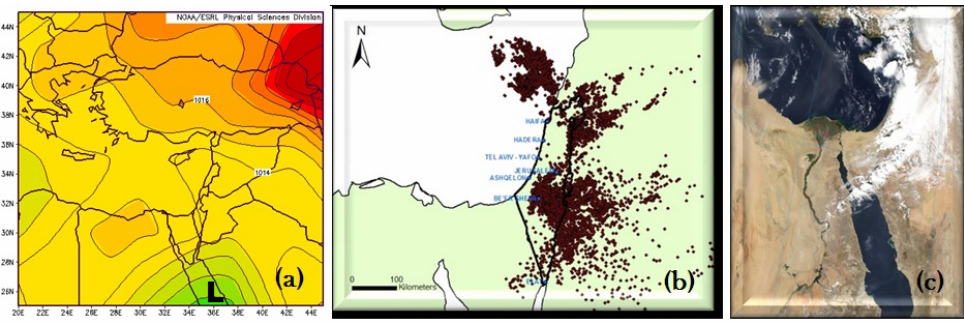
Fig. 7. The daily SLP map (hPa, a ), the daily distribution of the lightning flashes (b) and the MODIS satellite image (http://www.nasa.gov/ about/highlights/HP Privacy.html#links) taken at 11:00 UTC, for the “land” type, 29 October 2004.